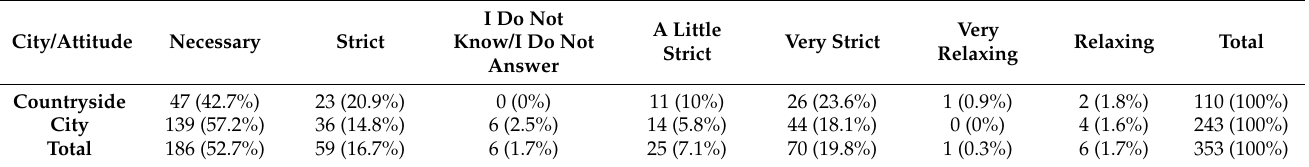
Table 3. Results for the measures of the State for coronavirus relating to the residence of believers. City/Attitude